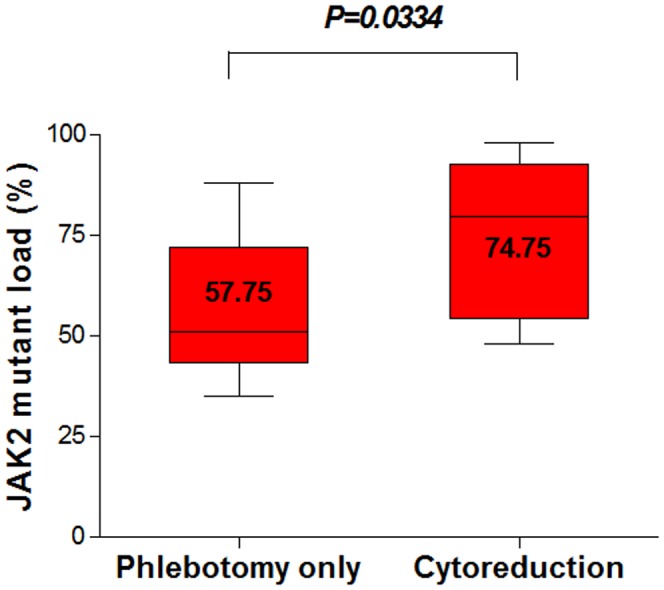
Proportion of the JAK2 V617F mutant according to treatment response in 15 PV patients with the JAK2 V617F mutation.
JAK2 mutant load predicted treatment response and strategy at diagnosis.